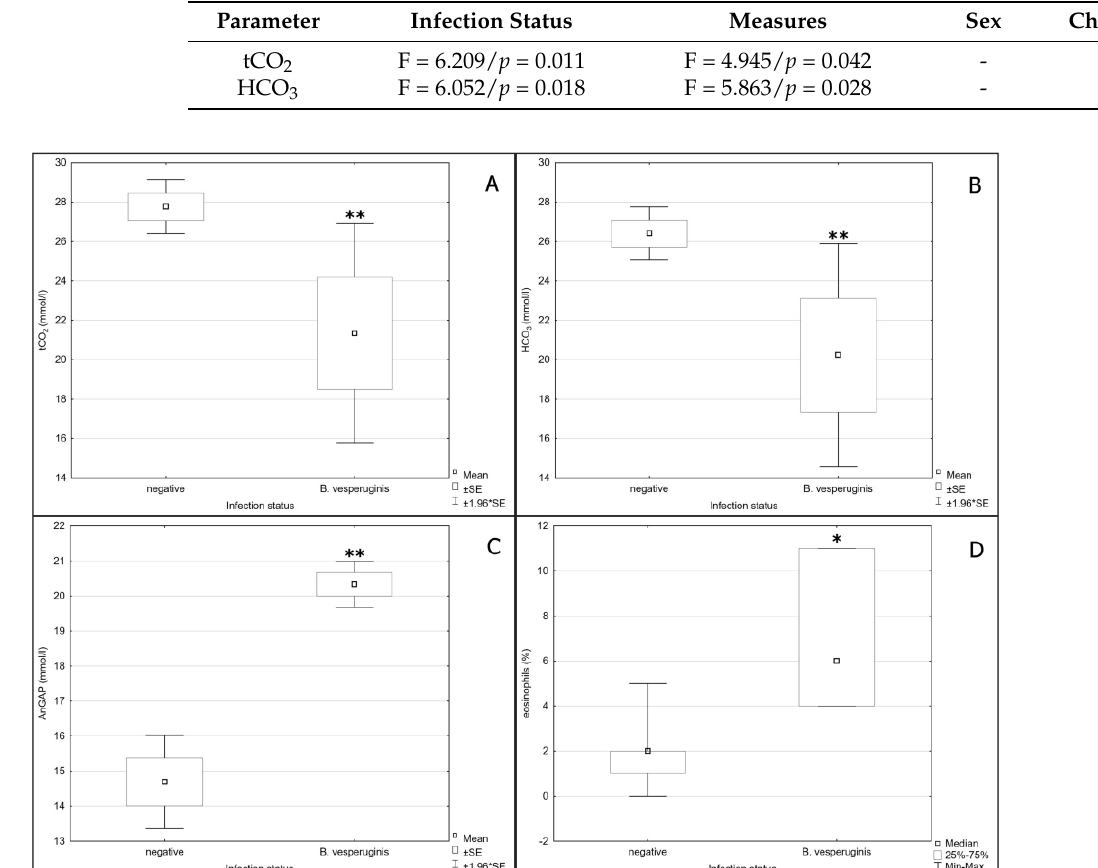
Figure 3. Differences of ( A ) total carbon dioxide values (negative – Babesia -negative, B. vesperuginis – Babesia -positive, p = 0.001589), ( B ) bicarbonate values (negative – Babesia -negative, B. vesperuginis – Babesia -positive, p = 0.002188), ( C ) anion gap values (negative – Babesia -negative, B. vesperuginis – Babesia -positive, p = 0.003313) and ( D ) eosinophils (negative – Babesia -negative, B. vesperuginis – Babesia -positive, p = 0.020801) in blood of a Babesia -positive bats in hibernation; * = p < 0.05, ** = p < 0.01. Table 3. Repeated Measures ANOVA in parameters influenced by infection status.